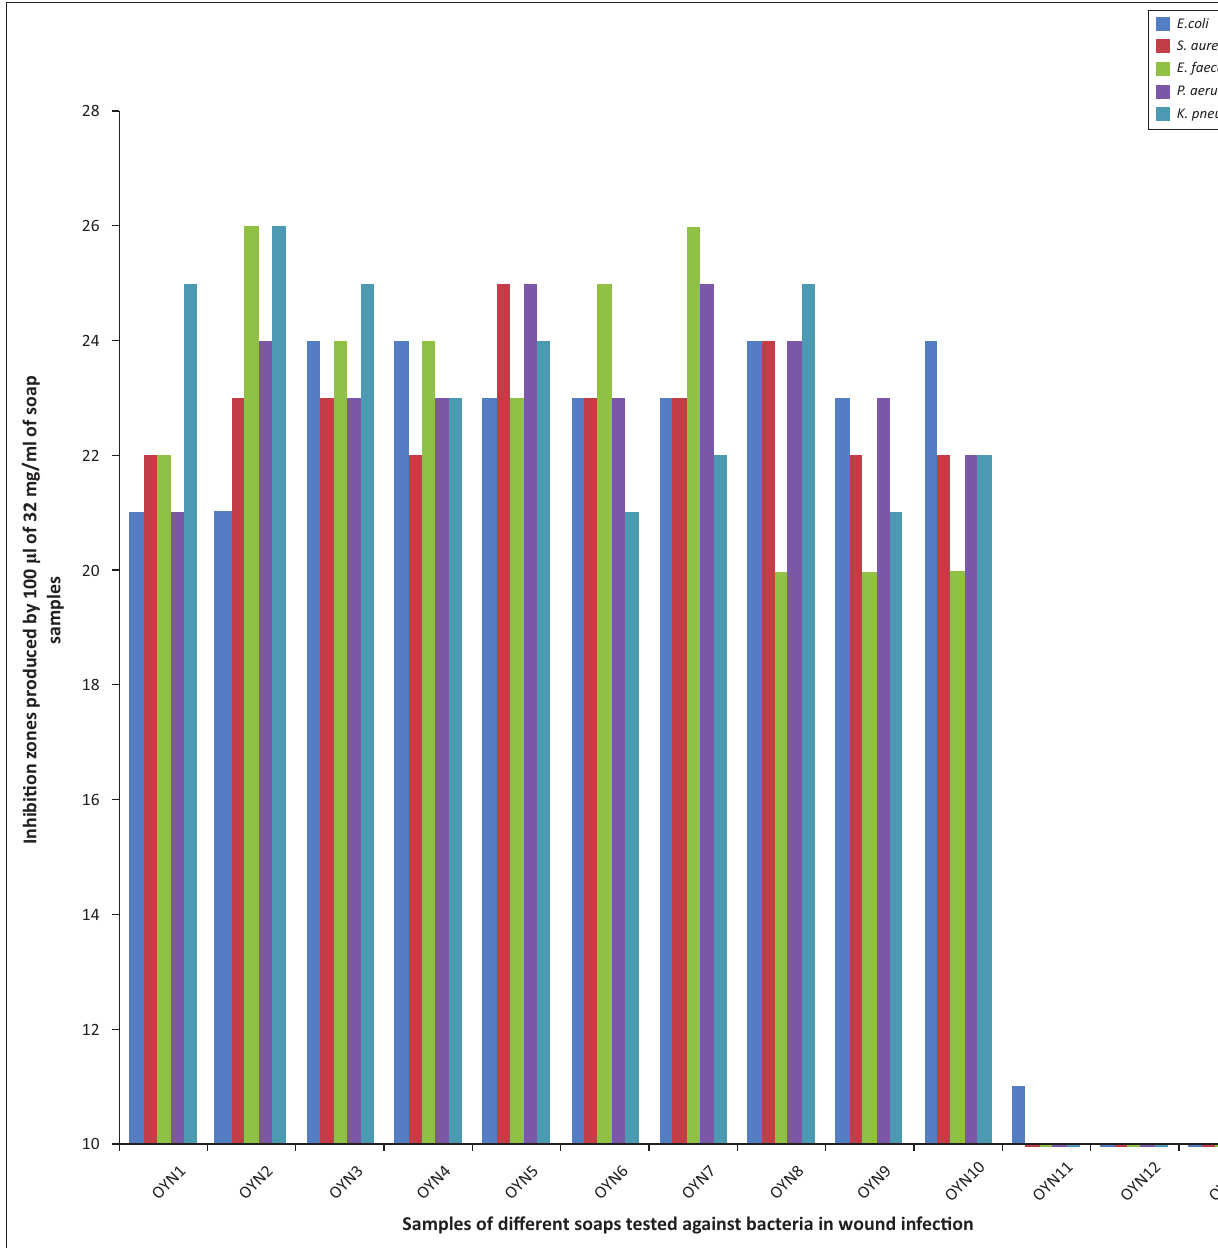
FIGURE 1: Susceptibility of bacterial isolates to 100 µ L of 32 mg/mL of different soap